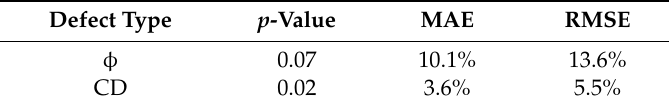
Table 4. p -value and errors of the quadratic models.